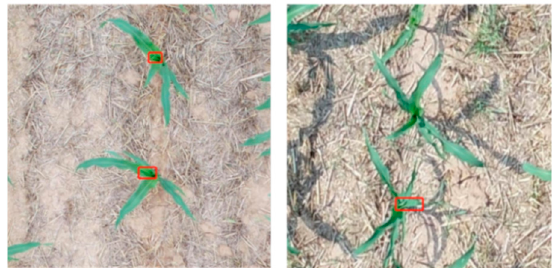
Figure 1. Examples of newly appeared leaf labeling. Newly appeared leaves are in the red rectangular boxes.